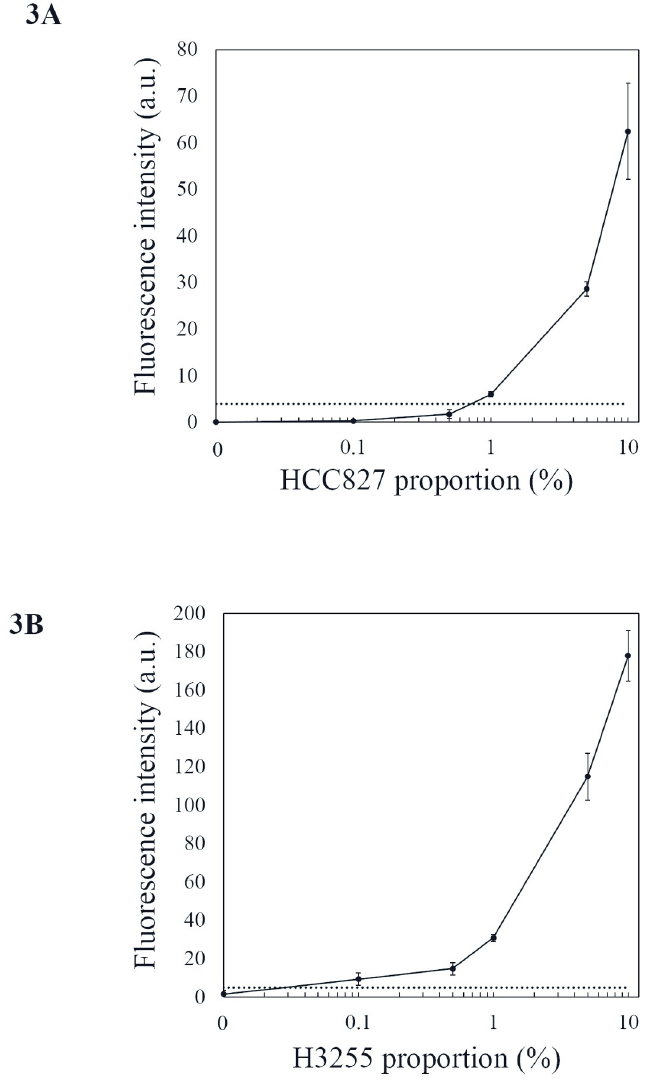
Fig 3. Calibration curves derived from mutant EGFR cell lines. Fluorescence intensities associated with (A) E746_A750 deletion and (B) L858R substitution versus background device fluorescence. The dashed lines indicate fluorescence values three standard deviations above the average for the EGFR WT cell line (H358) detected in each immuno-wall device.